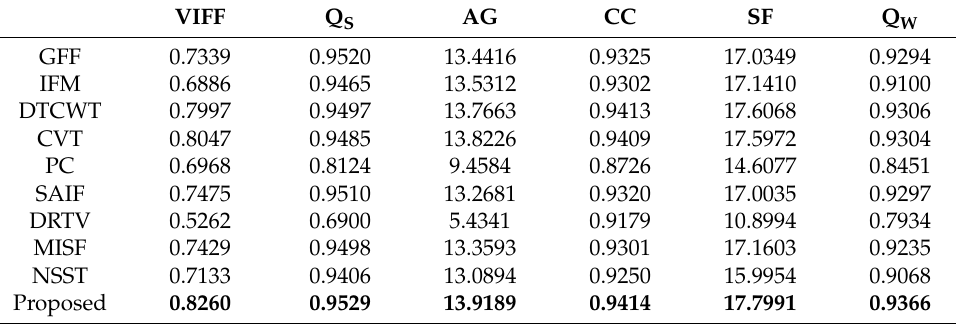
Table 4. The objective evaluation of the methods in Figure